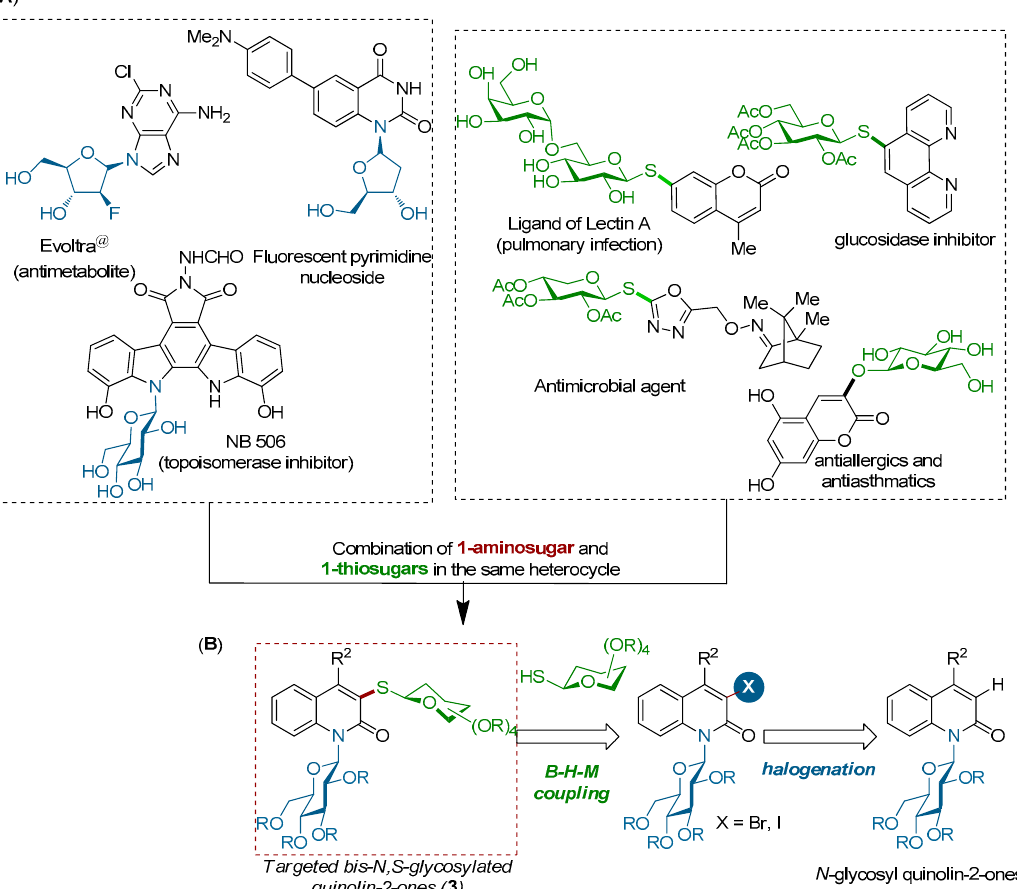
Figure 1. ( A ) Heteroaryl glycoside-based bioactive molecules; ( B ) General structure of the targeted - N,S - bis- glycosylated quinolinones ( 3 ).